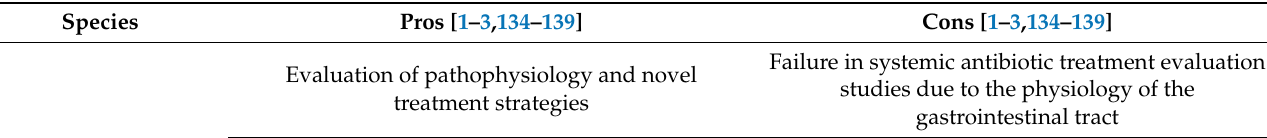
Table 1. Pros and cons of using animal models of human osteomyelitis.